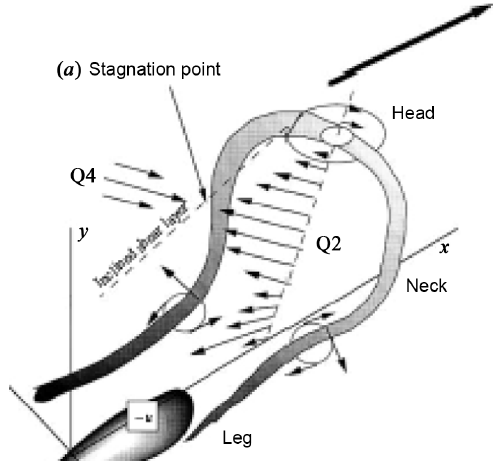
Fig. 3. The detected by Adrian hairpin-like